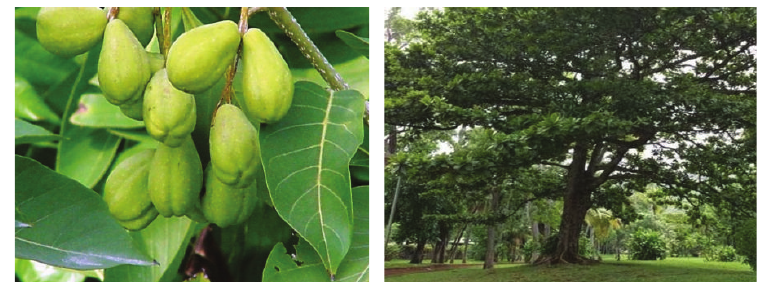
Figure 1: T. chebula tree and